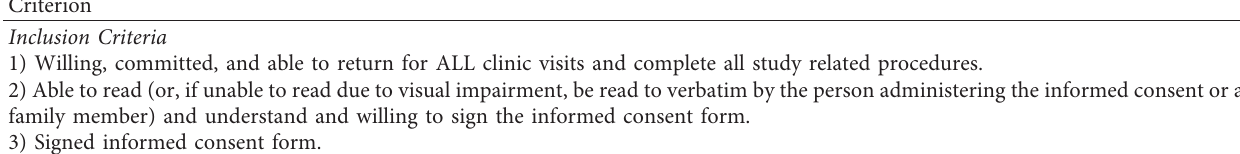
Table 1: Eligibility criteria of the VEGF Trap-Eye: Investigation of Efficacy and Safety in Wet AMD studies that could not be accurately assessed in the present study (category 1).